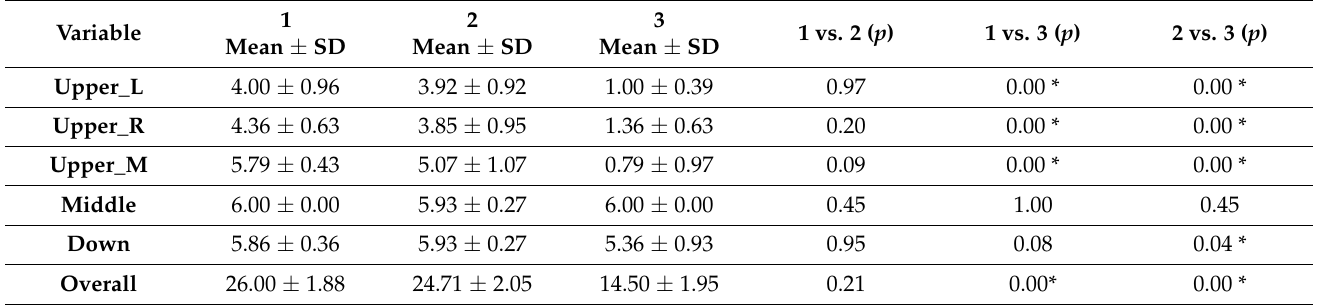
Table 2. Basic descriptive statistical parameters and Tukey’s post hoc results of ANOVA for each region for helmet non-users ( n = 21) (1—wearing only ski cap, 2—wearing ski cap and sunglasses, 3—wearing ski helmet and ski